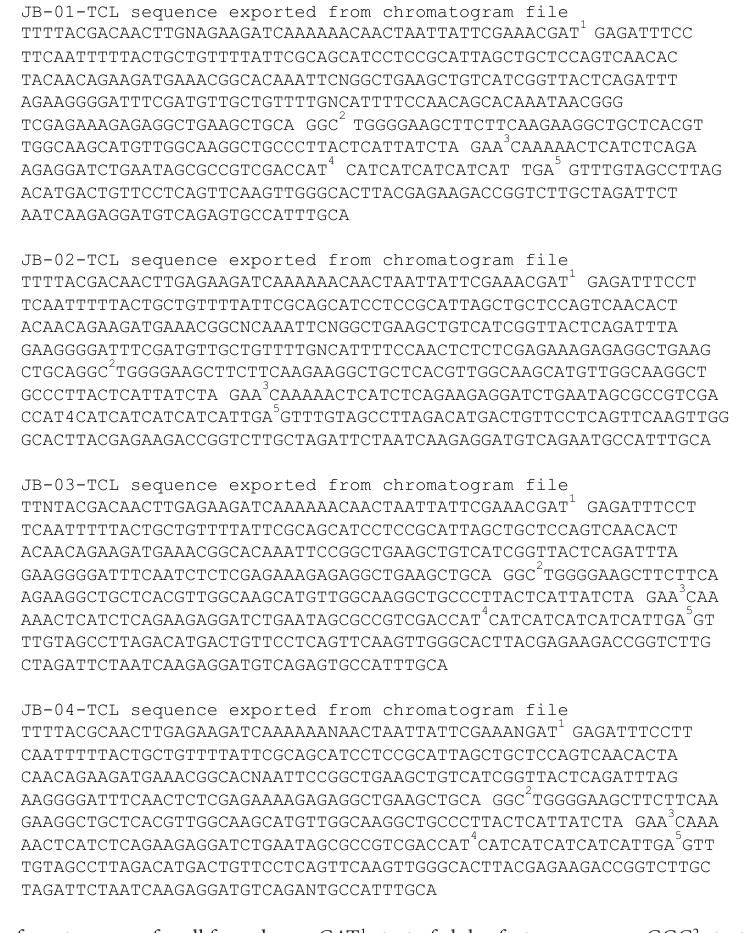
Figure 6. cDNA in ORF of yeast genome for all four clones. GAT 1 start of alpha-factor sequence. GGC 2 start of pleurocidin sequence. GAA 3 start of myc-epitope. CAT 4 Start of polyhistidine tag. TGA 5 stop codon.